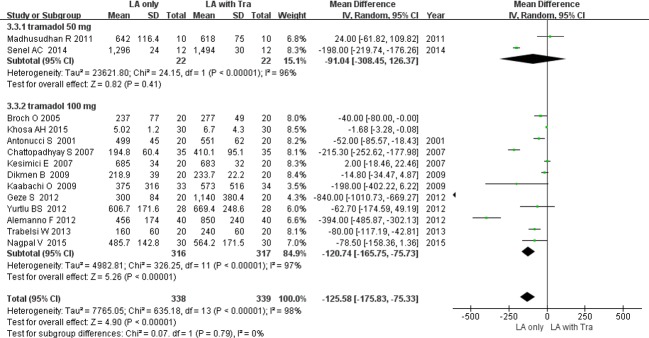
Forest plot demonstrating the duration of analgesia.Subgroup analysis by dose of tramadol. CI, confidence interval; LA, local anesthesia; SD, standard deviation; Tra, tramadol.